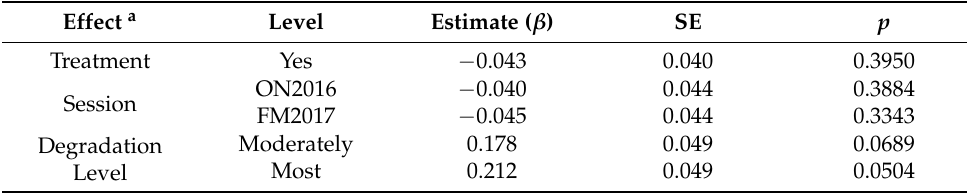
Table 2. Linear mixed effects model with treatment, session, and degradation level as fixed effects and species diversity (1- D ) as the dependent variable. Results show model coefficient estimates ( β ), the standard error of those estimates (SE), and associated p